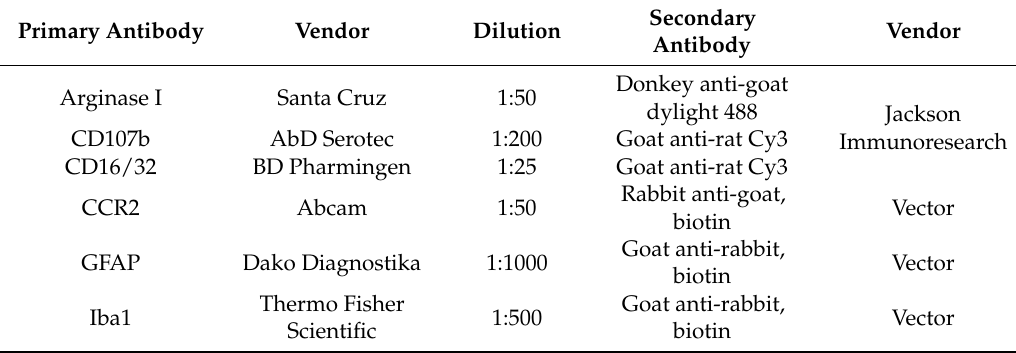
Table 1. Summary of antibodies used for detecting and discriminating astrocytes as well as microglia and/or